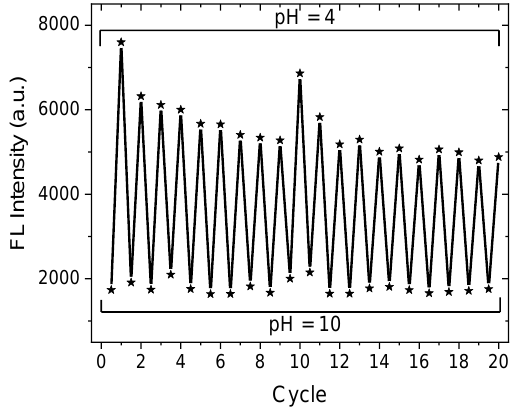
Figure 6. Circulation diagram of NFM2 in pH (4 and 10) solutions.